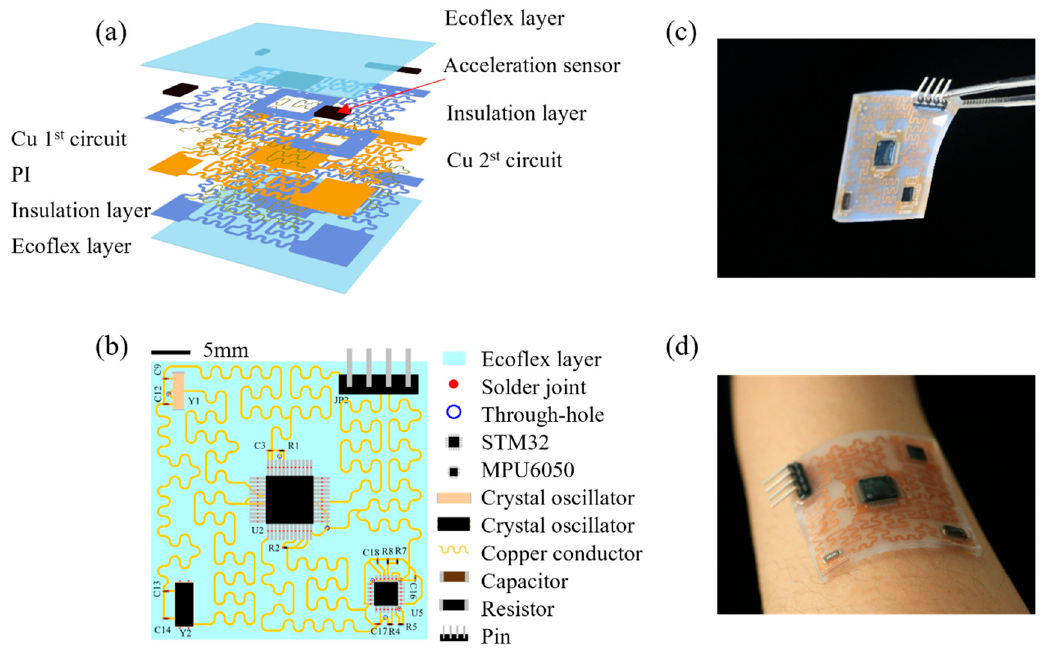
Figure 1. ( a ) Schematic exploded view illustration of the flexible acceleration sensor. ( b ) Two-dimensional schematic diagram of the flexible acceleration sensor. ( c ) Photograph of the flexible wearable acceleration sensor. ( d ) Photograph of the flexible wearable sensor attached to the human arm conformally.